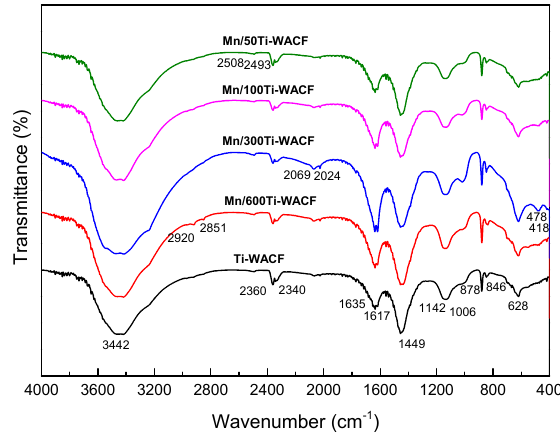
Figure 3. FTIR spectra of Mn/TiO 2 –WACF samples with different Mn doping concentrations.